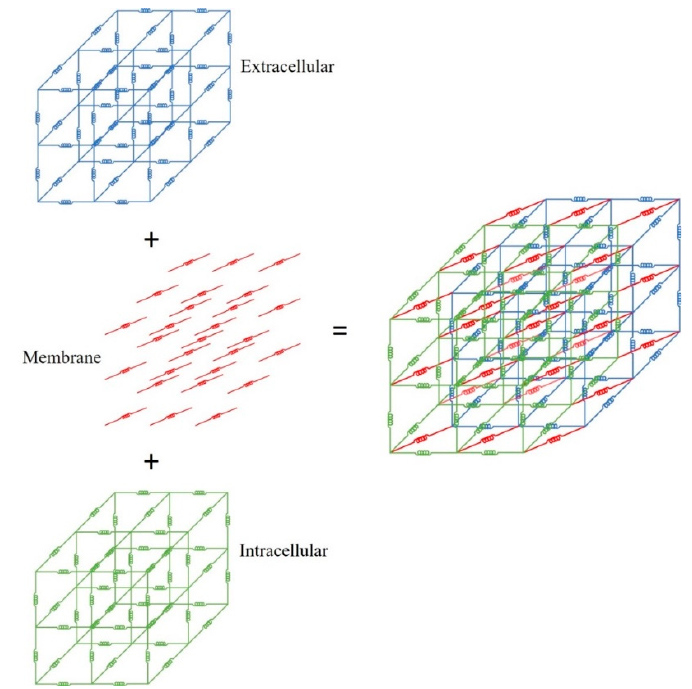
Figure 1. Three dimensional mechanical bidomain model. The networks of mechanical springs represent the mechanical properties of intracellular space (green), extracellular space (blue), and integrins in the membrane (red).